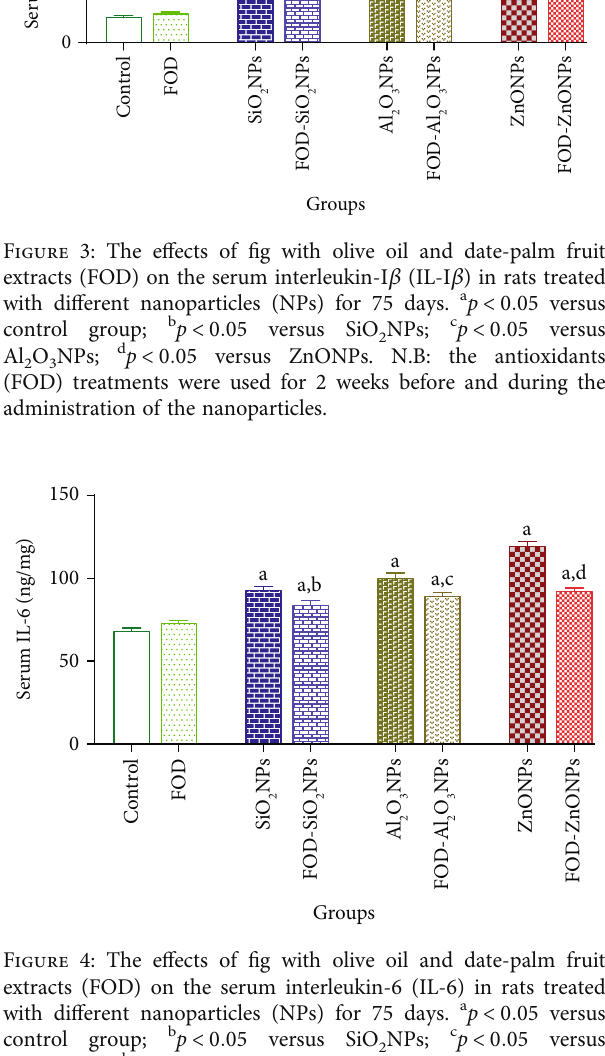
NPs; c p < 0 : 05 versus 2